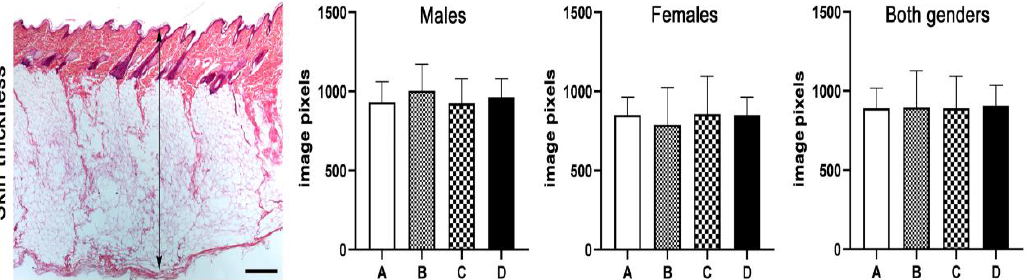
Figure 5. Skin thickness measurements (double-headed arrow) from female and male mink offspring. Experimental groups had comparable skin thickness at pelting period, irrespective of Spirulina diet status. Letters of x-axes correspond to the experimental groups (A, B, C,